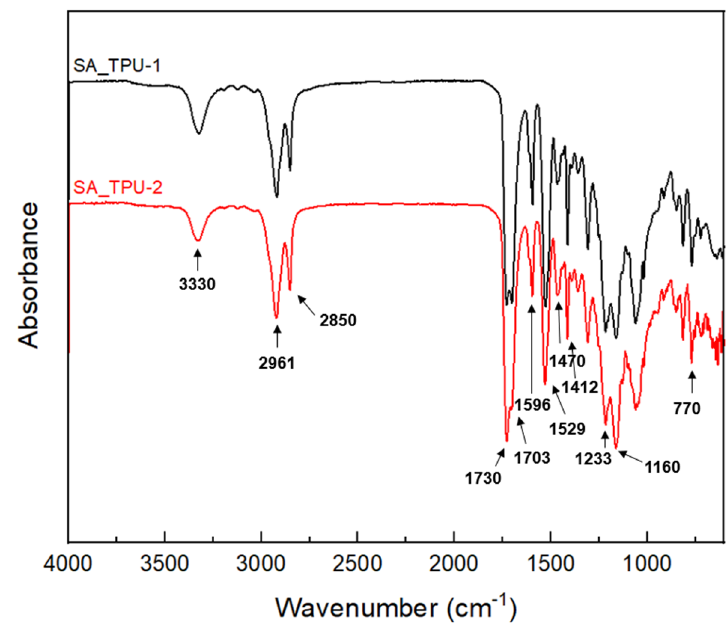
Figure 3. FT − IR spectra of synthesized TPU samples.